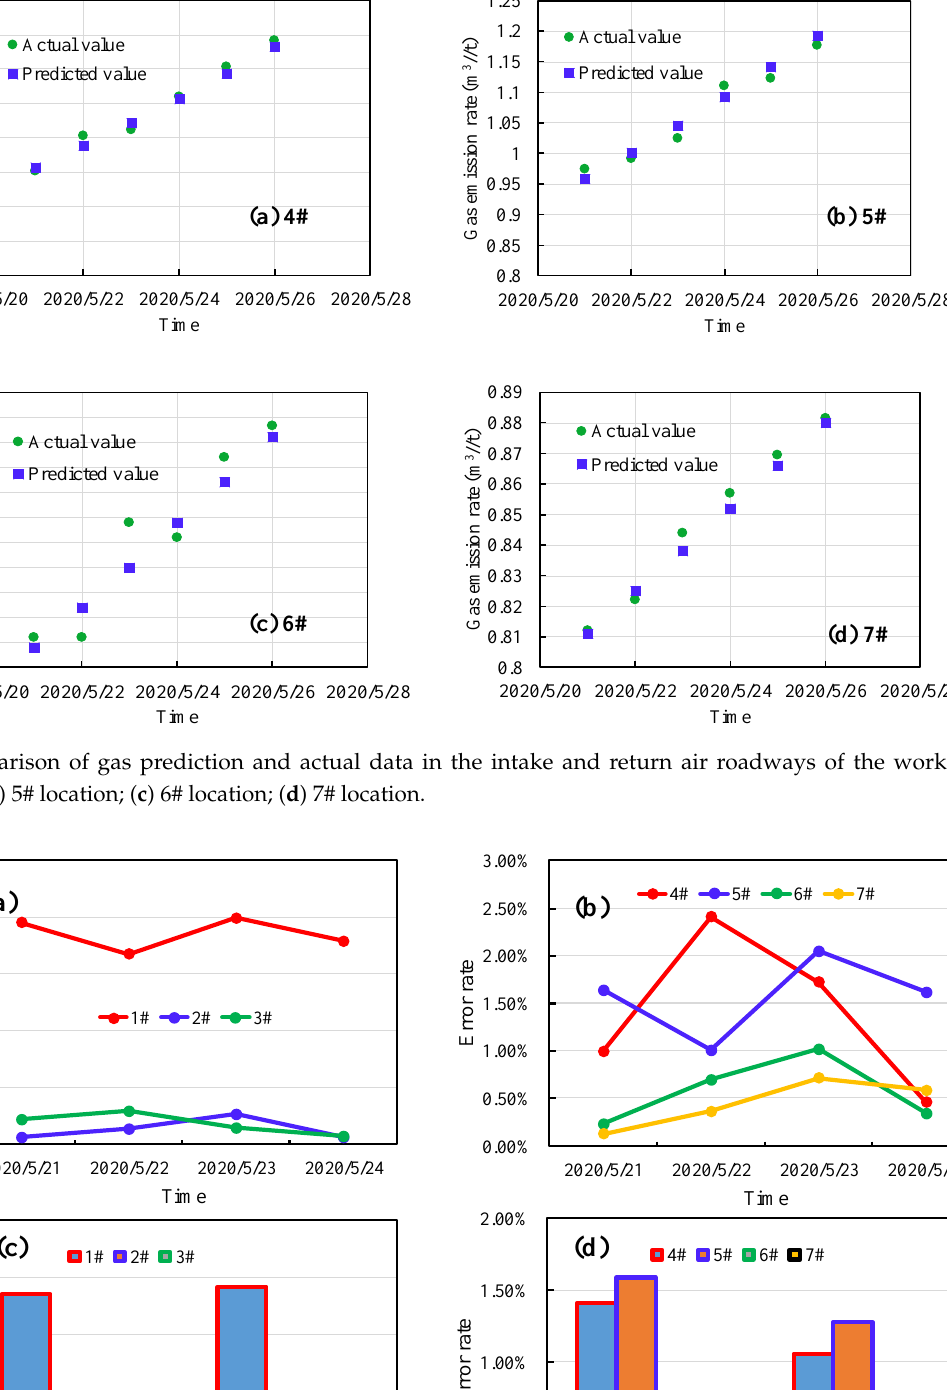
Table 4. Relative error between grey prediction result and measured value.